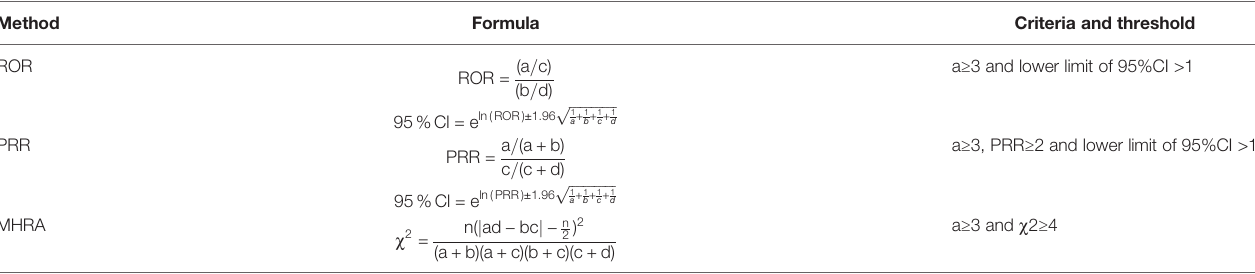
TABLE 1 | Formulas and criteria for generating signals of ROR, PRR and